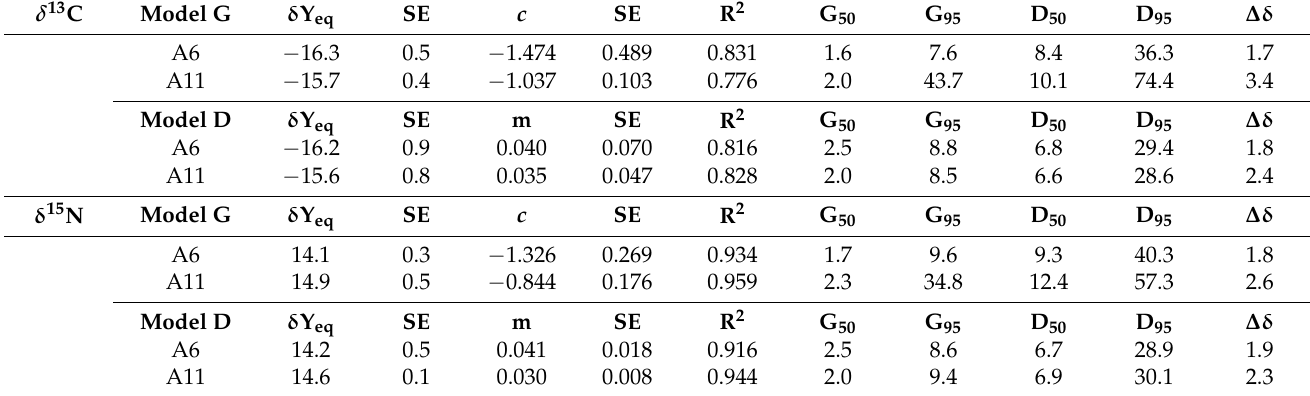
Table 2. Parameter estimates (mean ± SE) for best-fit models for growth and time